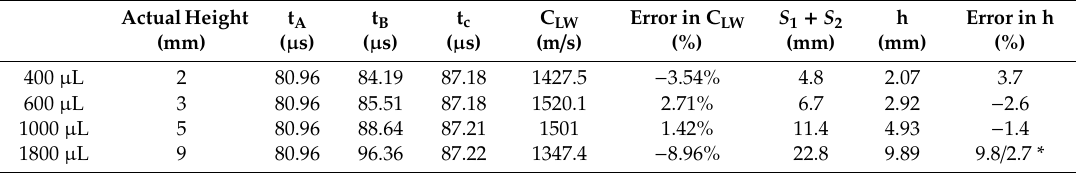
Table 4. Velocity and height